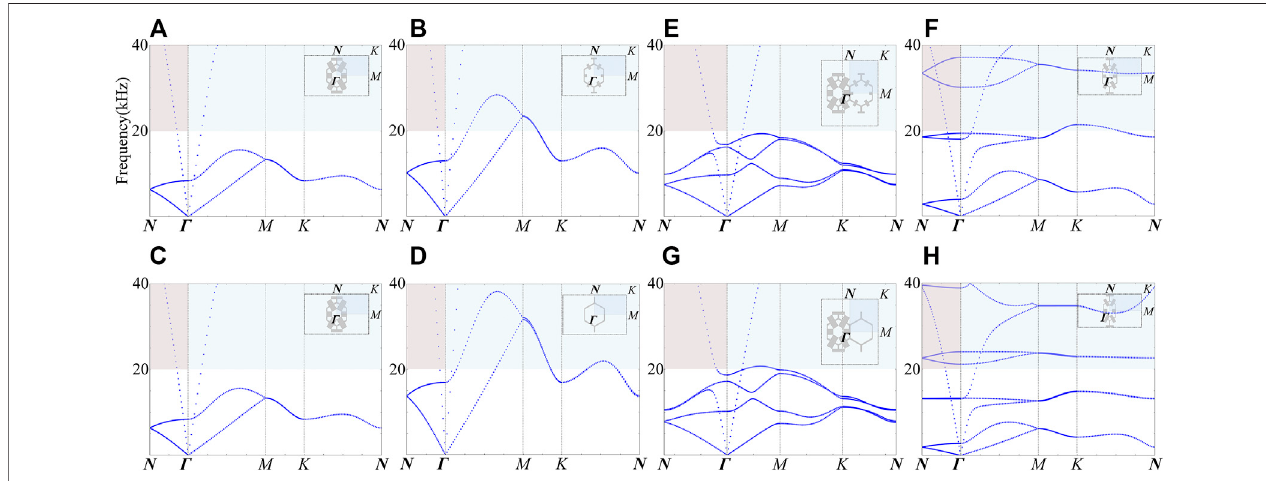
FIGURE3| Cellularstructuresandthefrequencydispersioncurves. (A) CellularstructureA. (B) CellularstructureB. (C) CellularstructureC. (D) CellularstructureD. (E) Microstructure A + B. (F) Microstructure C + D. (G) Cellular structure E. (H) Cellular structure F.